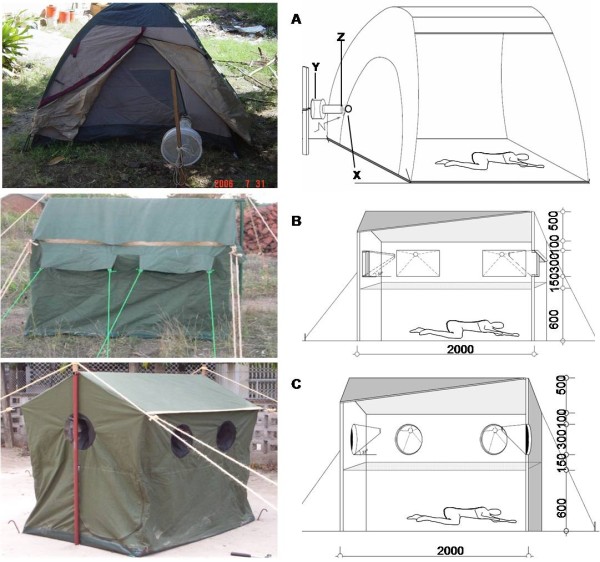
Furvela trap (A), Ifakara A tent trap (B), Ifakara B tent trap (C), with section drawing of each. The human occupant is protected from mosquito bites by a netting panel within the Ifakara A and B designs. For the Furvela trap, mosquitoes approach the small opening in the tent zipper (X) where they are drawn into the collection bag collection bag (Y) when they pass the CDC light trap entrance (Z), while in the Ifakara designs they enter through a funnel shaped entrances tilted upward. All dimensions in mm.